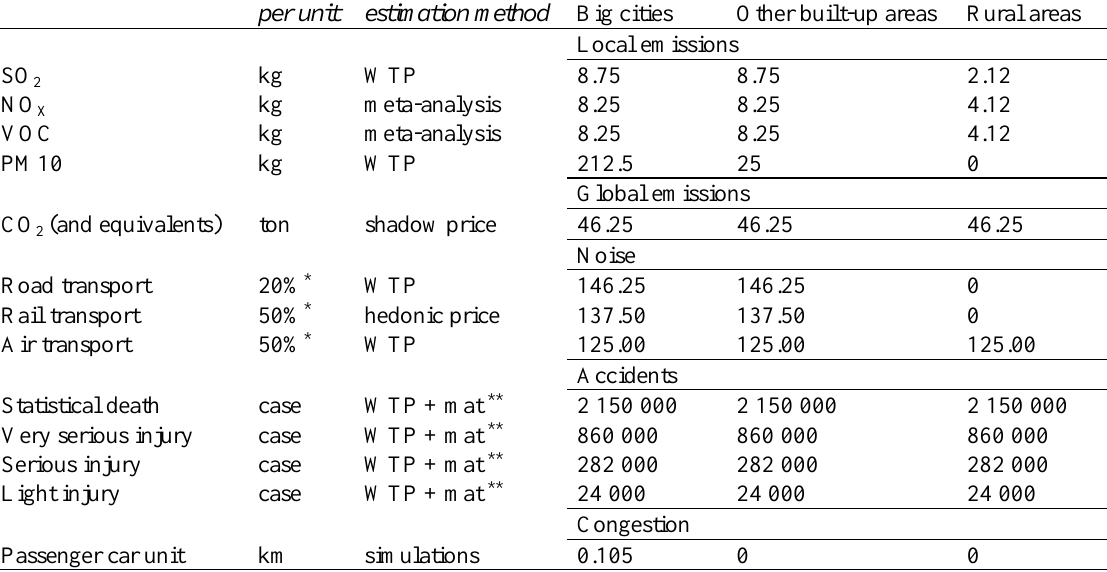
Table 1. Estimation methods and basic unit costs after type of external cost